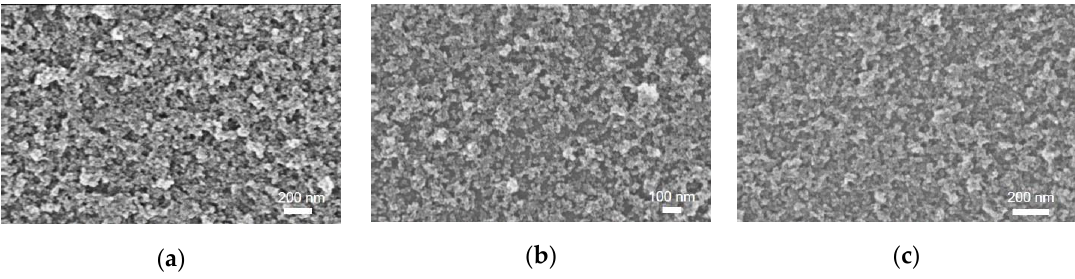
Figure 7. SEM images of ( a ) CCO, ( b ) 5% Mg:CCO, and ( c ) 10% Mg:CCO films on ITO substrates.